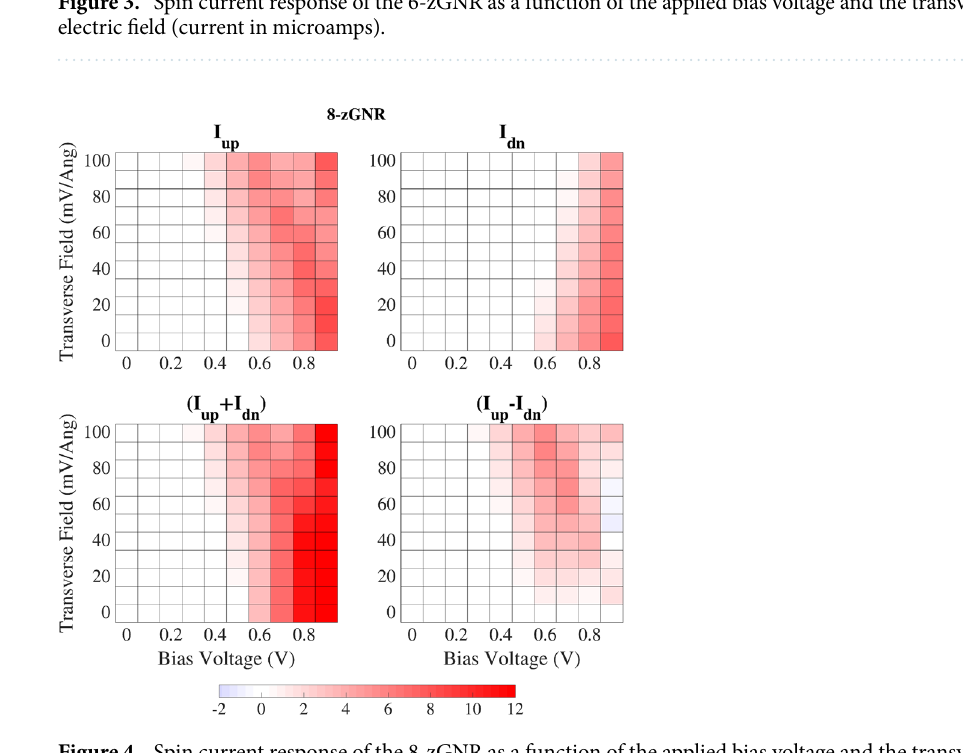
Figure 4. Spin current response of the 8-zGNR as a function of the applied bias voltage and the transverse electric field (current in